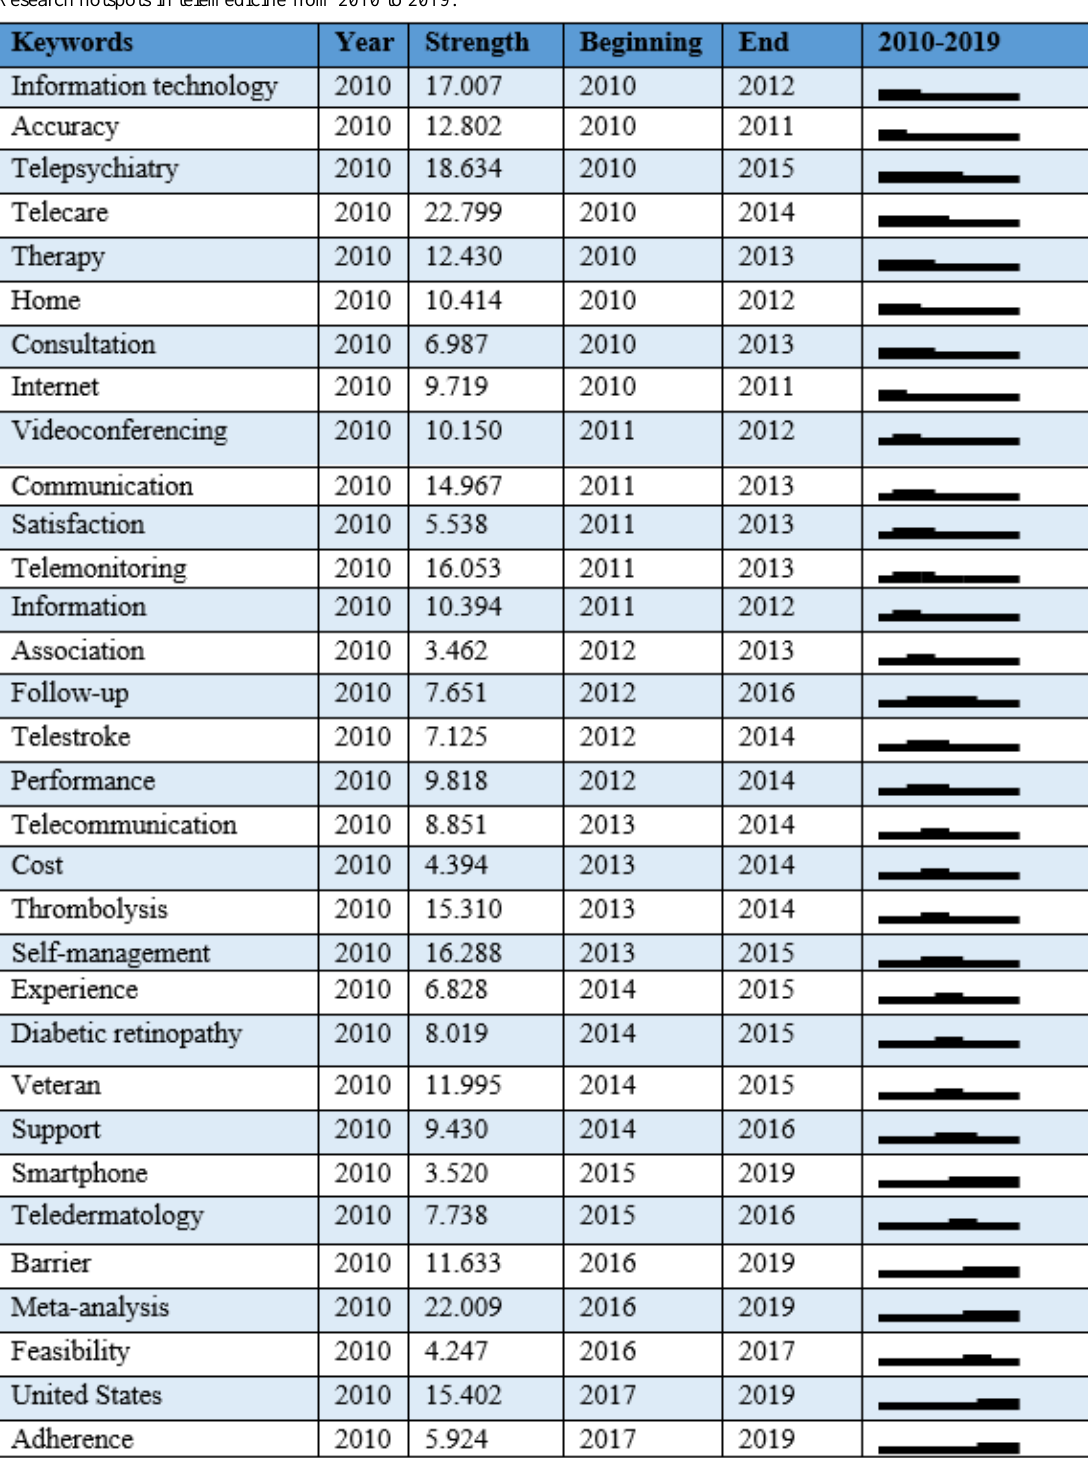
Figure 6. Research hotspots in telemedicine from 2010 to